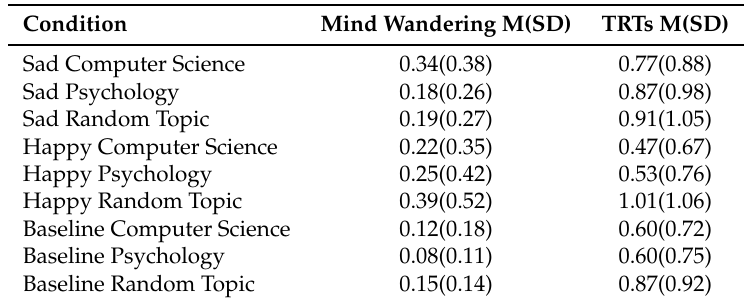
Table 2. Descriptive